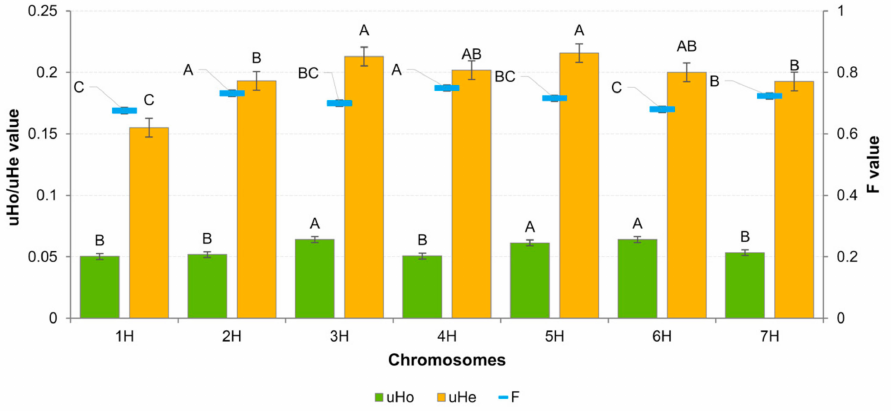
Figure 3. Summary of the diversity coefficient values across barley chromosomes for 83 cultivars based on DArTseq data. Letters above the bars in the graph indicate homogeneous groups determined by Tukey’s post hoc